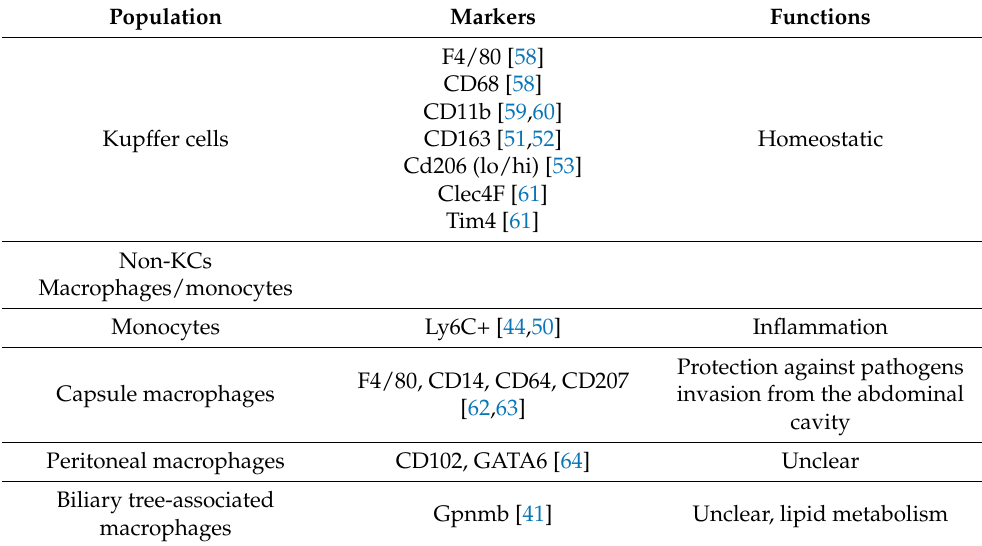
Table 1. Macrophage populations of the